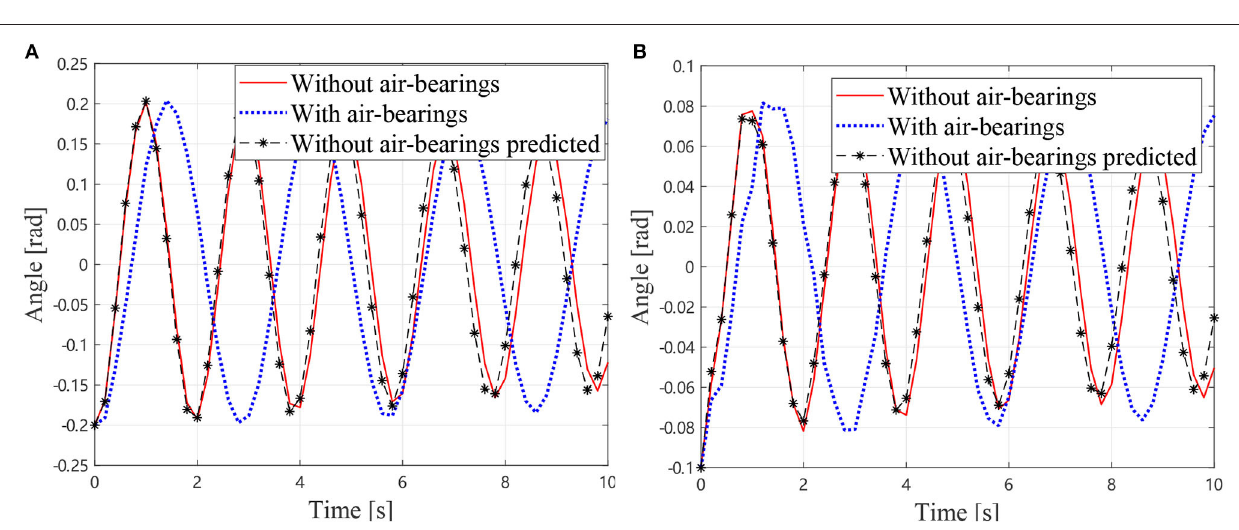
FIGURE 7 | Simulational vibration angles without air bearings, (A) Angles of J 1 (B) Angles of J 2